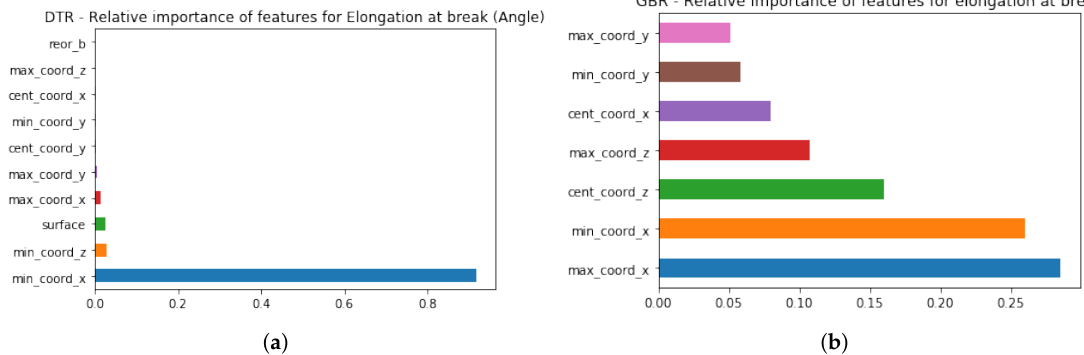
Figure 12. Relative importance of the features based on the specimen orientations ( a ) Elongation at break—Angle orientation. ( b ) Elongation at break—All